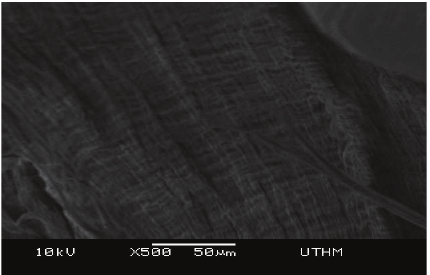
Figure 8: SEM image for fractured neat HDPE at 500x